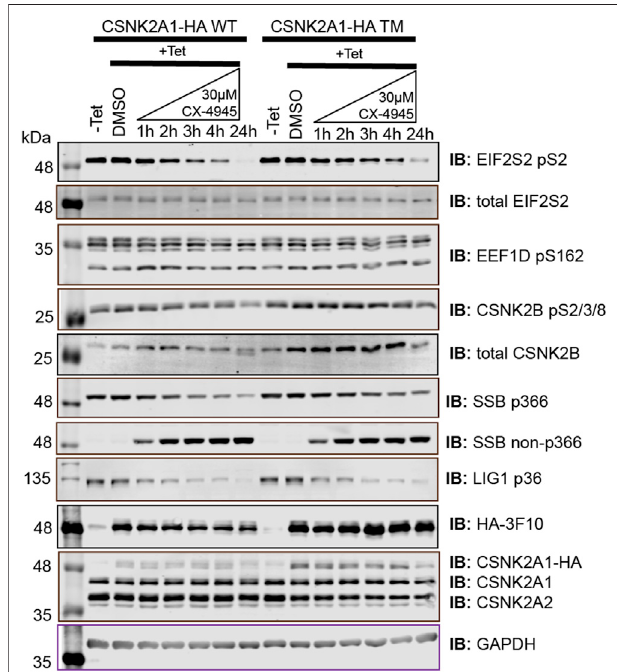
FIGURE 5 | Immunoblot evaluation of phosphospeci fi c antibodies recognizing SSB pS366, SSB S366, and LIG1 pS36. Flp-In T-REx U2OS cell lines stably expressing CSNK2A-HA WT or CSNK2A-HA TM with tight Tetracycline (Tet-ON) regulation weretreated with30 µM ofCX-4945for the indicated times and blotted with the indicated antibodies recognizing total protein or speci fi c sites. Results are representative of two independent